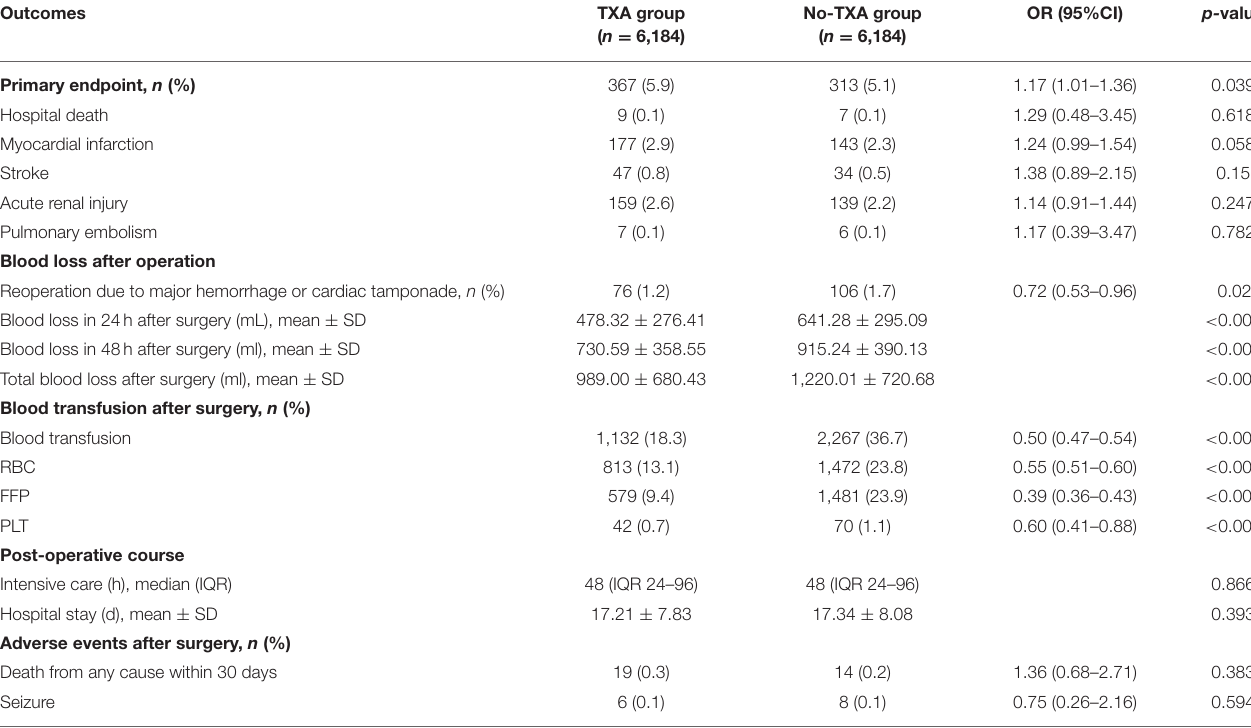
TABLE 3 | Adjusted odds ratios in patients with OPCAB for primary and secondary endpoints between the TXA group and no-TXA group by PSM.